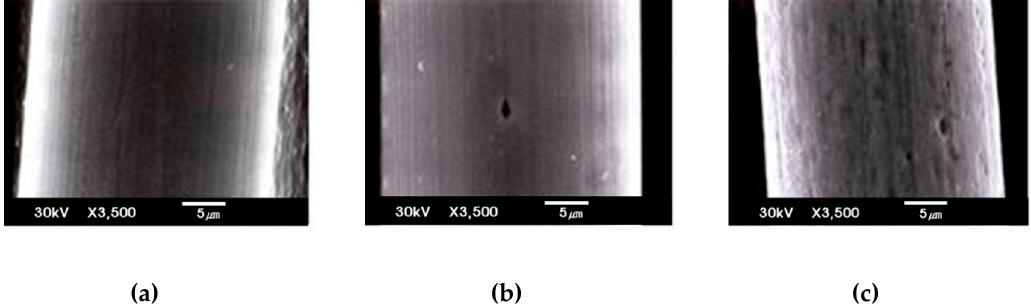
Figure 6. SEM micrographs (3500 X) of the stainless-steel fibers ( a ) without the acid treatment and after ( b ) 20 min and ( c ) 60 min of the acid treatment.